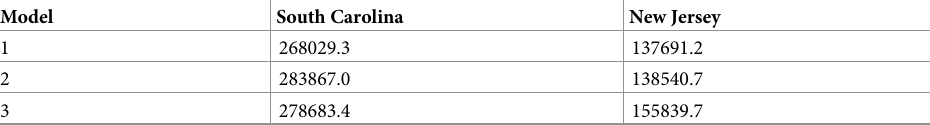
Table 10. WAIC goodness of fit for mobility models.